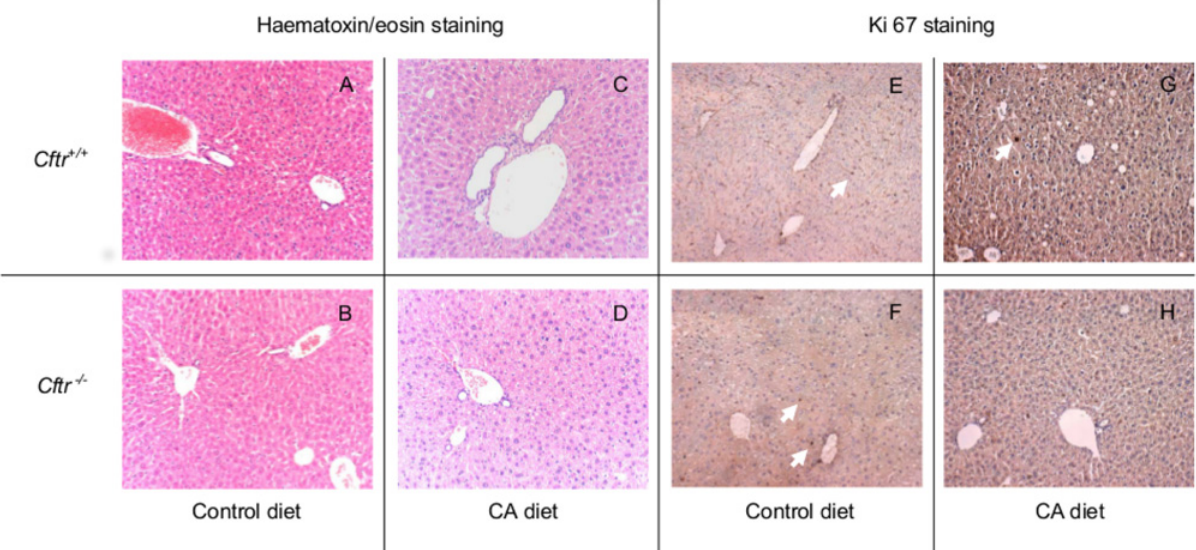
Fig 6. Liver histology of Cftr knockout mice (Cftr -/- ) and controls, fed a control diet or a cholic acid (CA) containing diet for 3 weeks. Liver histology (magnification 40x) of Cftr knockout mice ( Cftr -/- ) and control littermates ( Cftr +/+ ) after a control or 0.5%-CA containing diet for three weeks. Liver slices with HE staining (panels: A-D), or Ki67 staining on HE staining background (panels: E-H). The white arrows, pointing at Ki67 positive cells indicate active cell proliferation in parenchymal and portal areas.